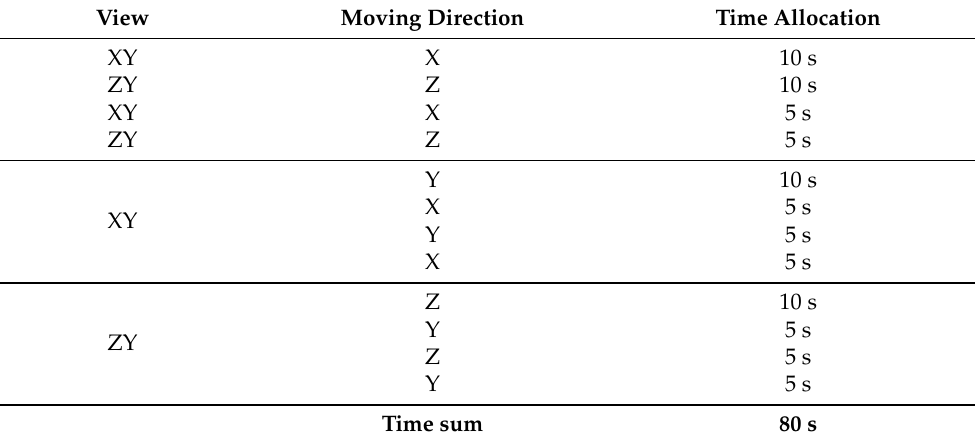
Table 2. Protocol for the unit measurement: Measurements followed the pre-defined sequence of movements and measurement steps, with specifications on the view switch and moving direction, as well as the time allocation for each